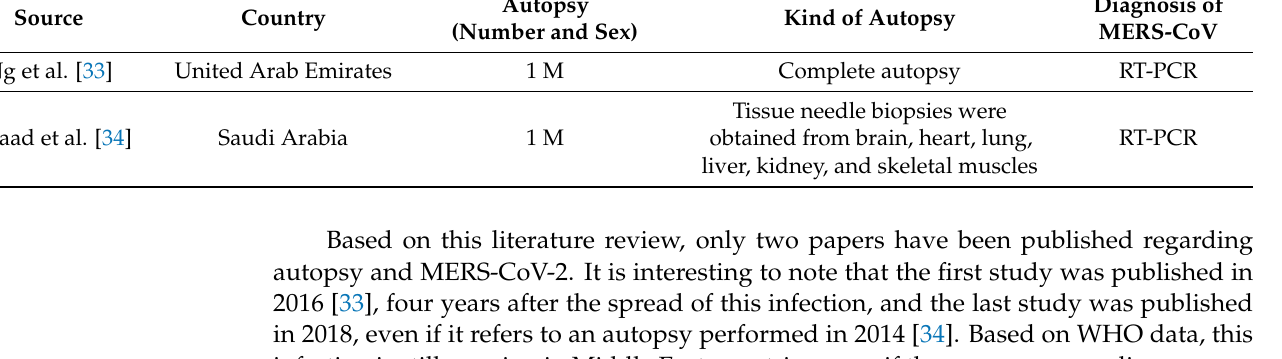
Table 2. General data obtained analyzing the studies included in this literature review matching the keywords “Autopsy” OR “Post-mortem” AND “MERS” (Middle East Respiratory Syndrome).